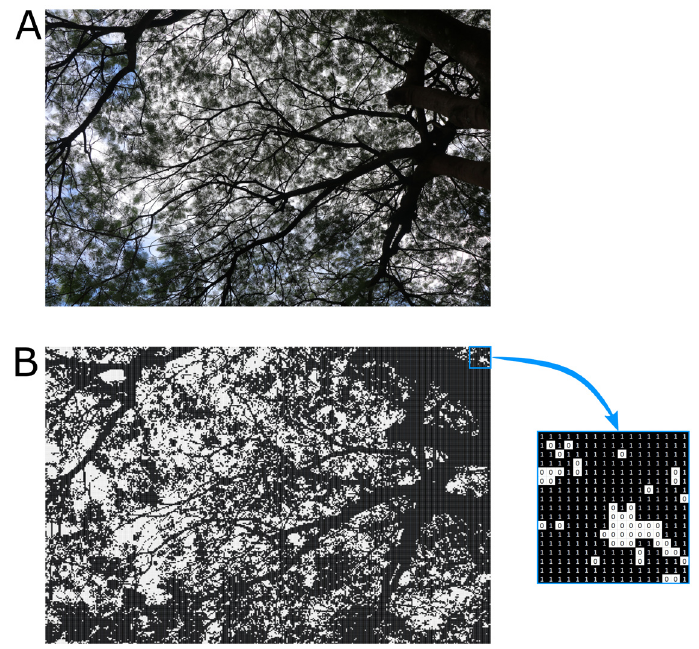
Figure 1. General approach for image analysis in the bwimage package. A ) An image of a natural structure is obtained with digital photography; here we used an image from a canopy. B ) The image is converted into a binary matrix, functions threshold_color (to a single image) or threshold_image_list (for two or more images). In the data matrix the value one represents black pixels, zero represents white pixels and NA represents transparent